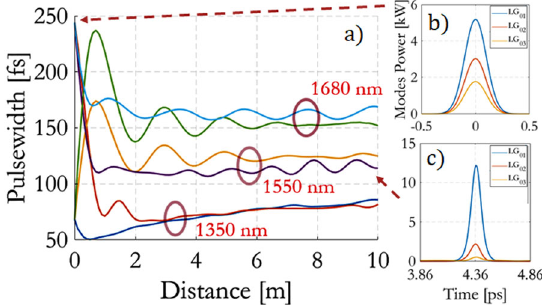
Fig. 6 Evolution with fi ber length of simulated soliton pulsewidths for different input pulse durations and wavelengths. Simulations for input pulses of 67 and 235 fs duration, and wavelengths of 1350, 1550, 1680 nm, respectively ( a ). The input modes are LG 01 , LG 02 , LG 03 . Modal powers at the fi ber input ( b ), and after 10 m of propagation ( c ), for input 1550 nm input wavelength and 235 fs input